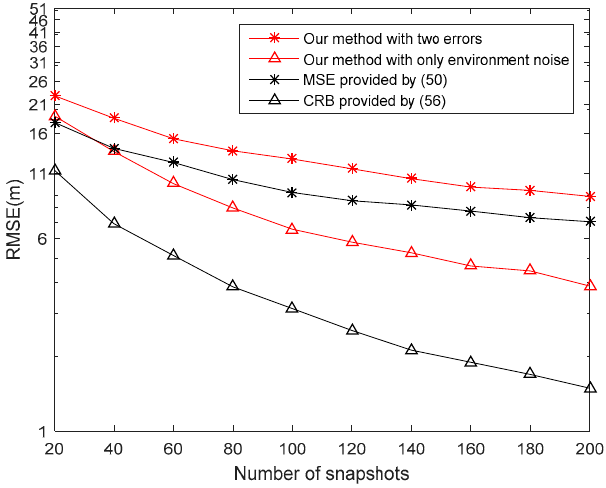
Figure 7. RMSEs versus number of snapshots.